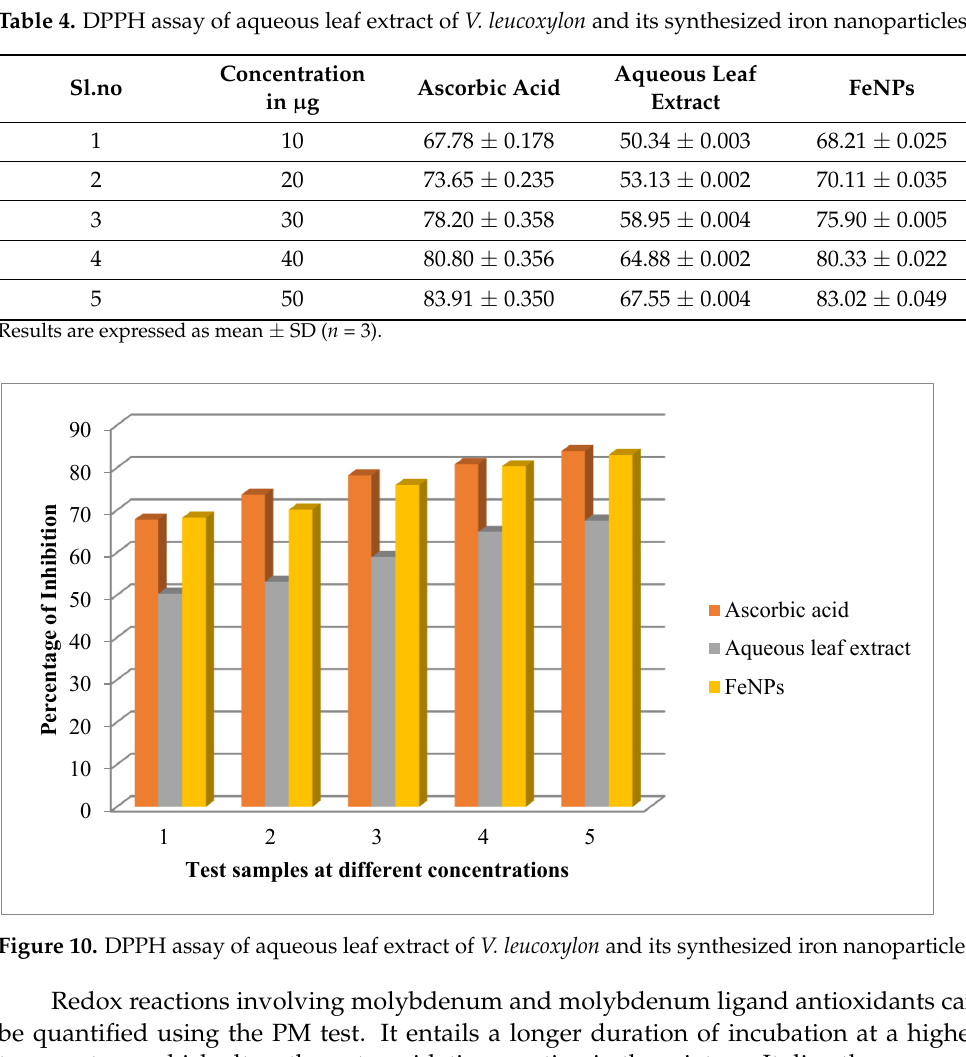
Table 3. H 2 O 2 assay of aqueous leaf extract of V. leucoxylon and its synthesized iron nanoparticles.